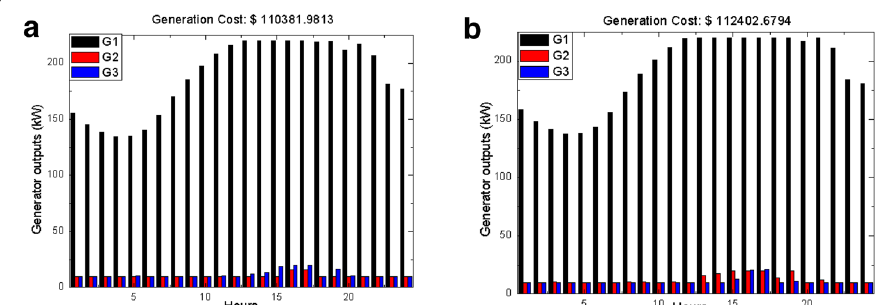
Fig. 8 Load sharing among DGs with wind support for a forecasted load profile. b Uncertainty load profile